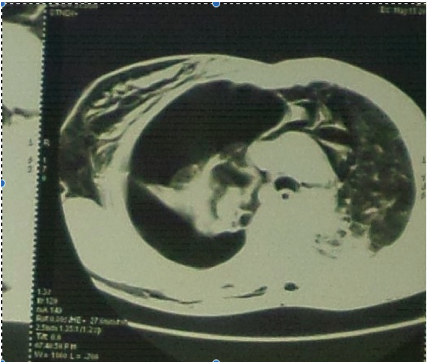
Figure 1: Chest CTscan transverse view. The aspergilloma cavity is seen at the apex of the right lung. There are massive pneumothorax with subcutaneous emphysema and bilateral lung fibrosis as se- quelae of tuberculosis.